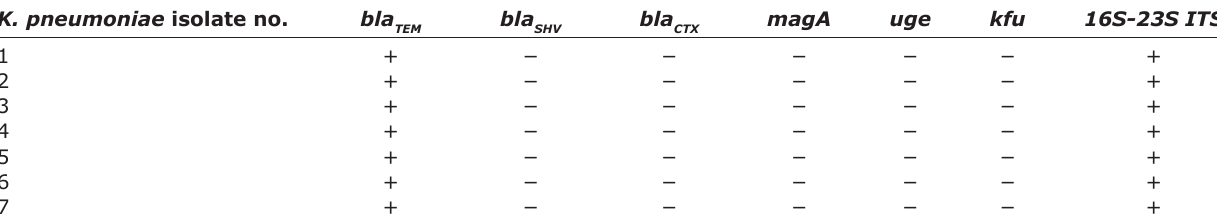
, bla , and bla ), virulence genes TEM SHV CTX